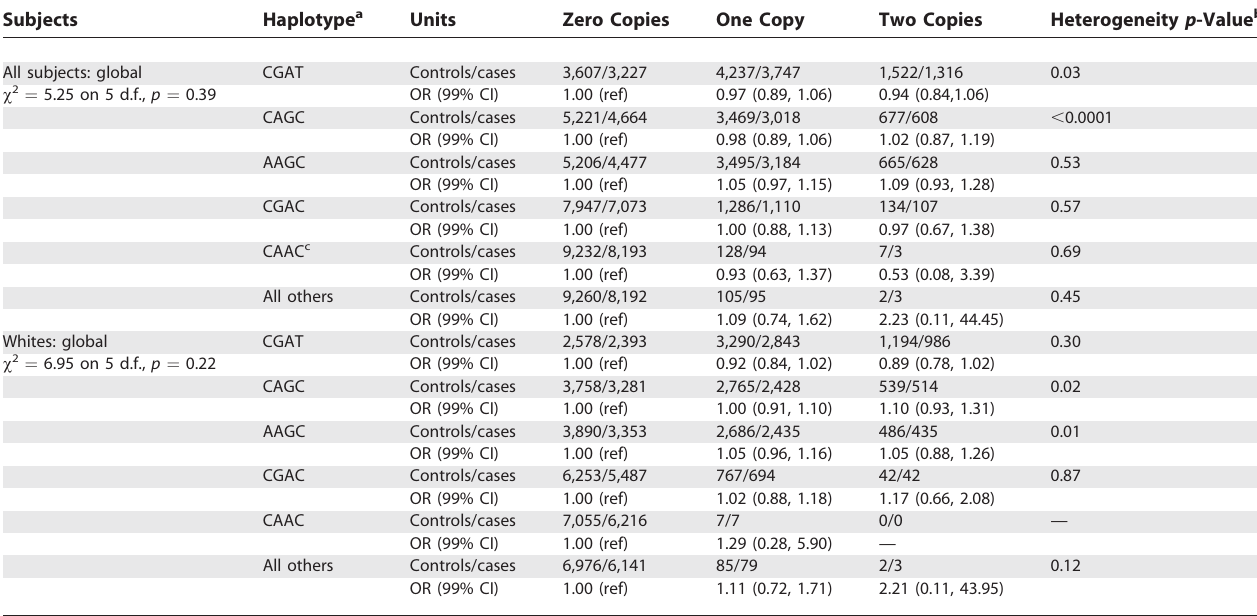
Table 4. HSD17B1 Haplotypes and Prostate Cancer Risk, BPC3 Subjects Haplotype a Units Zero Copies One